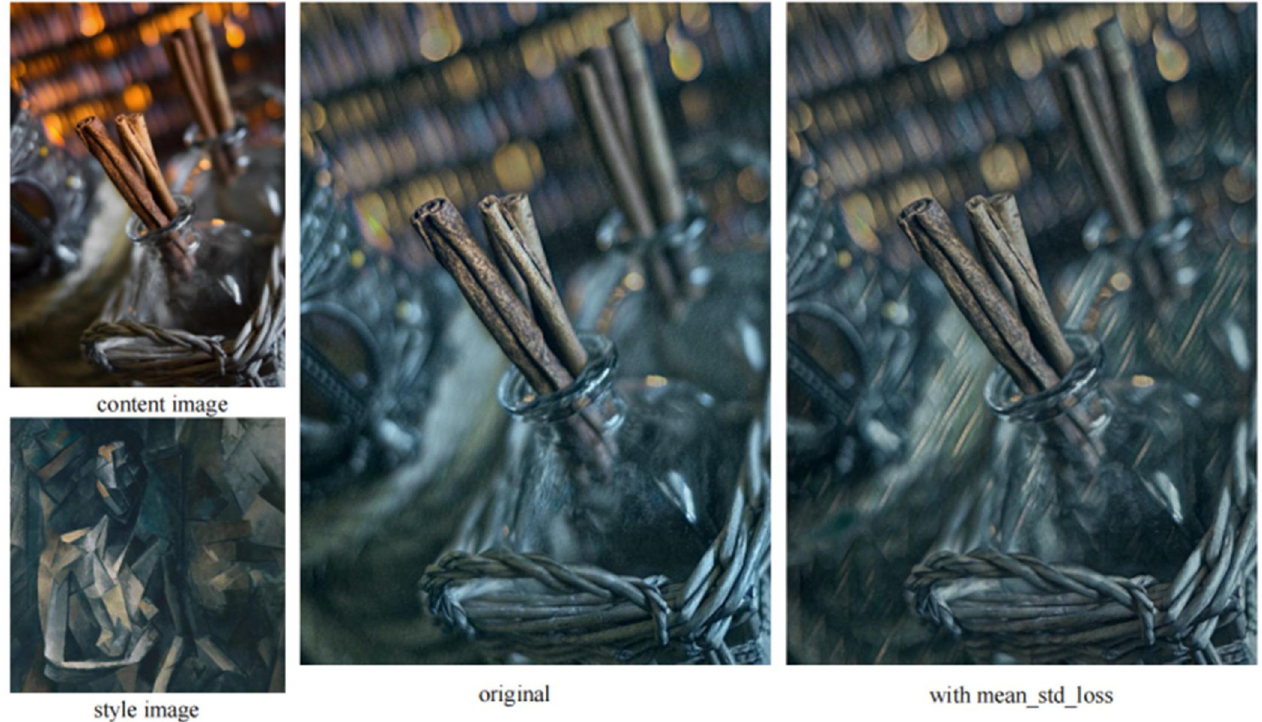
Fig 8. Comparison of effects before and after the introduction of mean standard deviation loss.